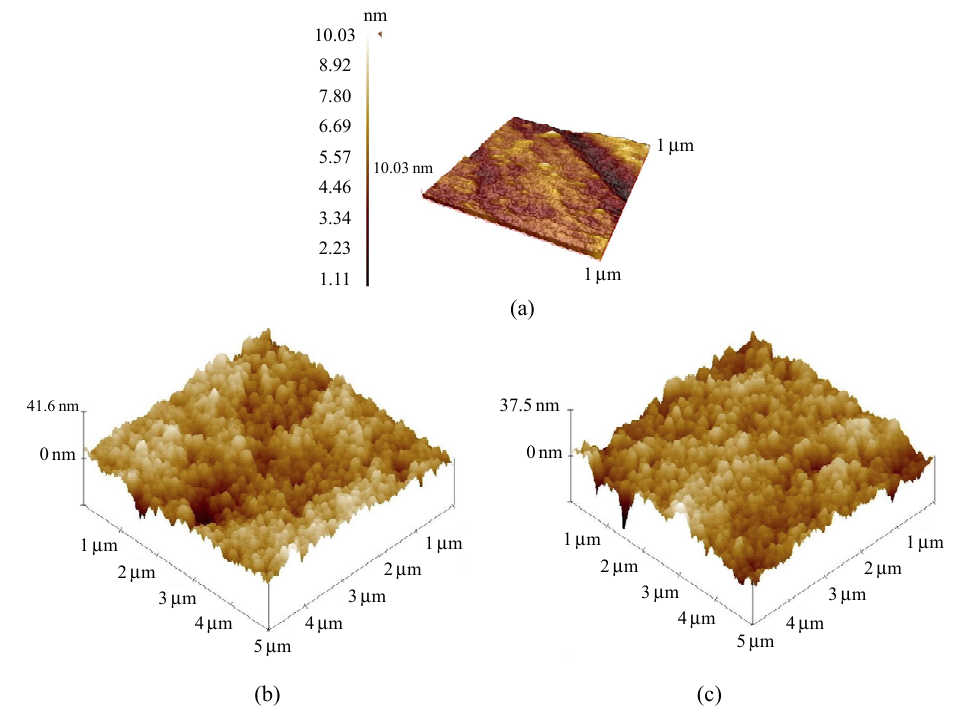
Fig. 4 AFM images: (a) unmodified SPR chip surface; (b) MIP and (c) NIP SPR sensors surfaces.